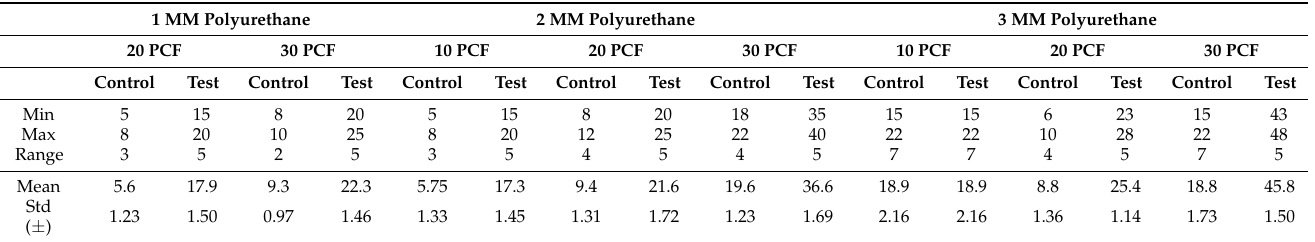
Table 2. Pull Out Strength values of Control Implants and Test Implants. CI = Control Implant; TI = Test Implant.